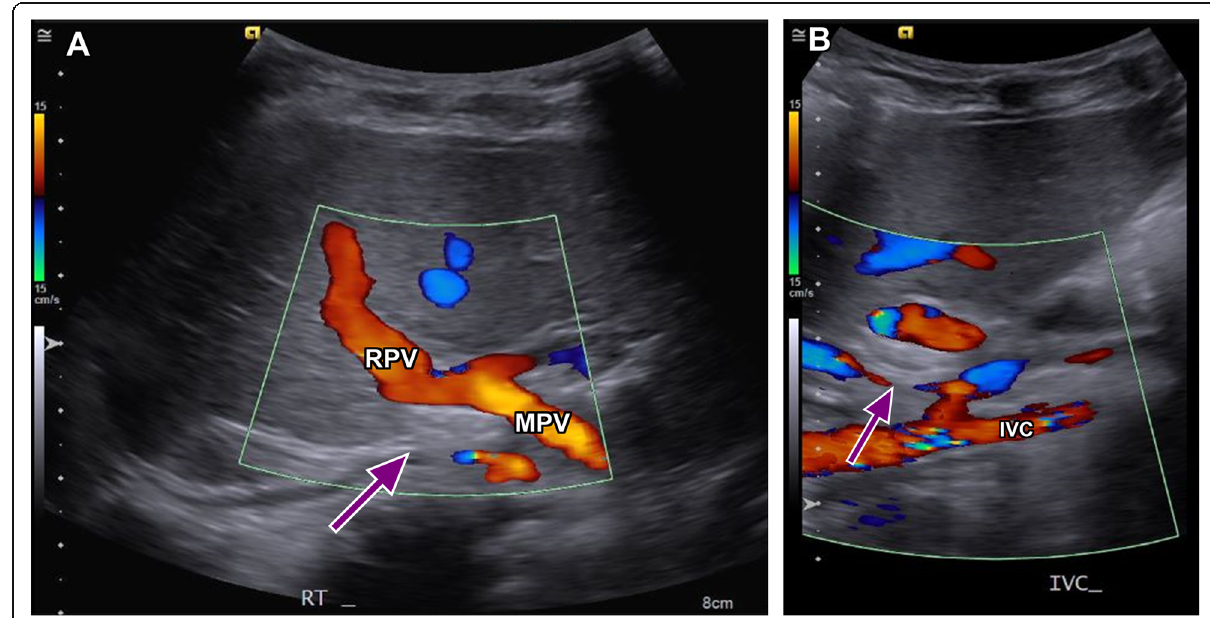
Fig. 4 Post-procedure imaging: Doppler ultrasound images of the liver at one-month follow-up. a The Amplatzer PFO OD (purple arrow) is seen within the expected location of the previously seen CPSS with patent hepatopetal flow of the main portal vein (MPV) (labeled) and RPV (labeled). b The IVC (labeled) is